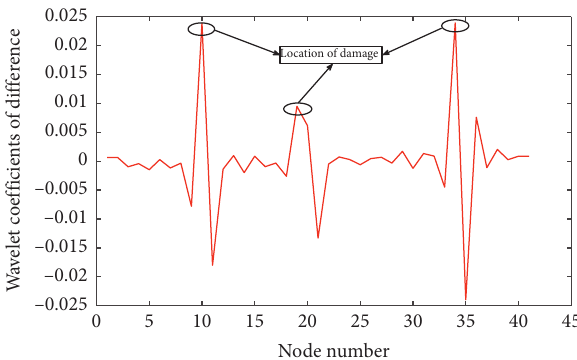
Location of damage